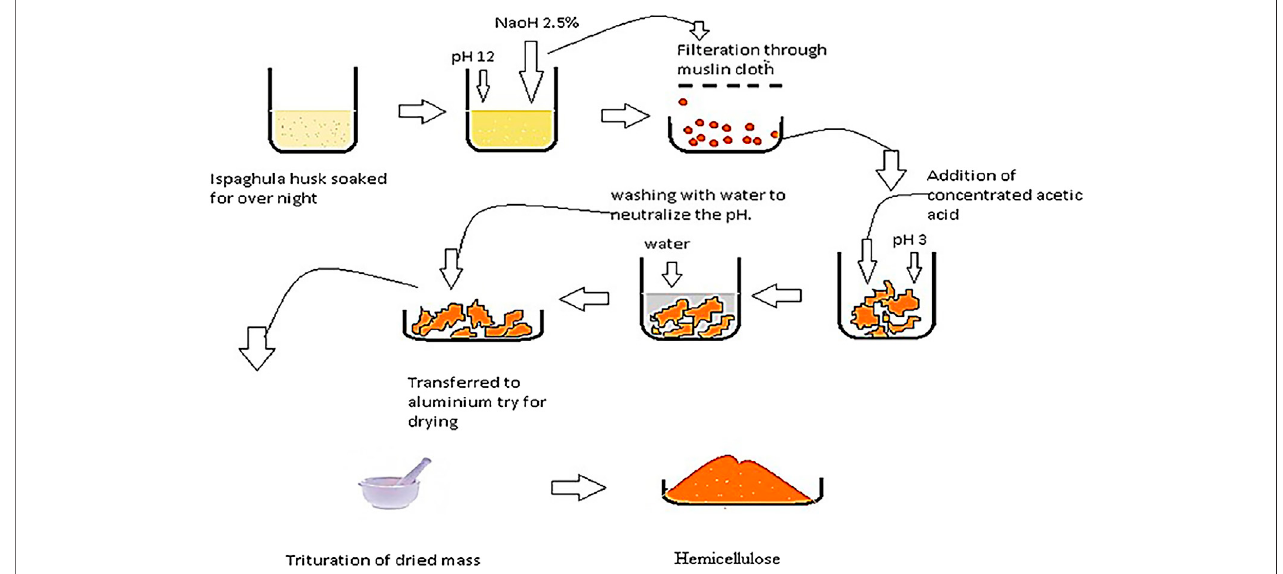
FIGURE 1 | Pictorial description of alkali extraction, used for the extraction of Hemicellulose from Ispaghula husk.